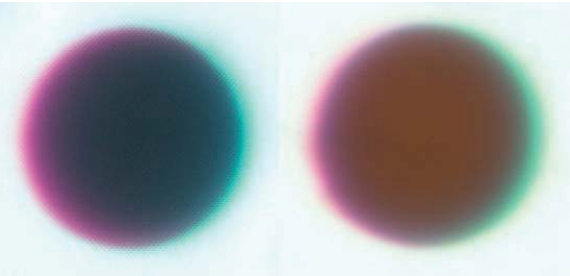
Figure 1. Representative beads dissected from the generalist Spodoptera eridania (Lepidoptera: Noctuidae) larvae reared upon ( left ) Taraxacum officinale , a high-quality diet, and ( right ) Plantago lanceolata , a low-quality diet [75]. Host plants were determined to be high or low quality based on observations of growth rate, and defensive chemistry of the two plant species. Photos by E.C.